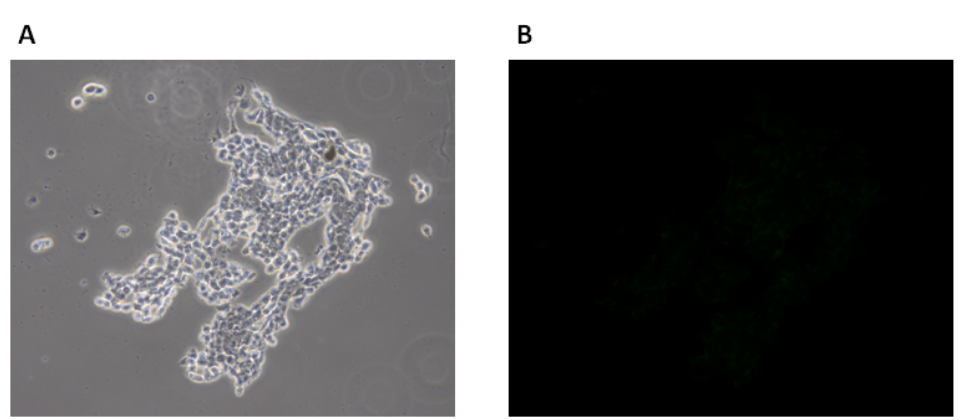
Figure 6. Fluorescence microscopy of HCT116 cells after treatment with fluorescein. ( A and C ): Phase contrast images of different regions. ( B and D ): Respective fluorescence microscopy images of the same